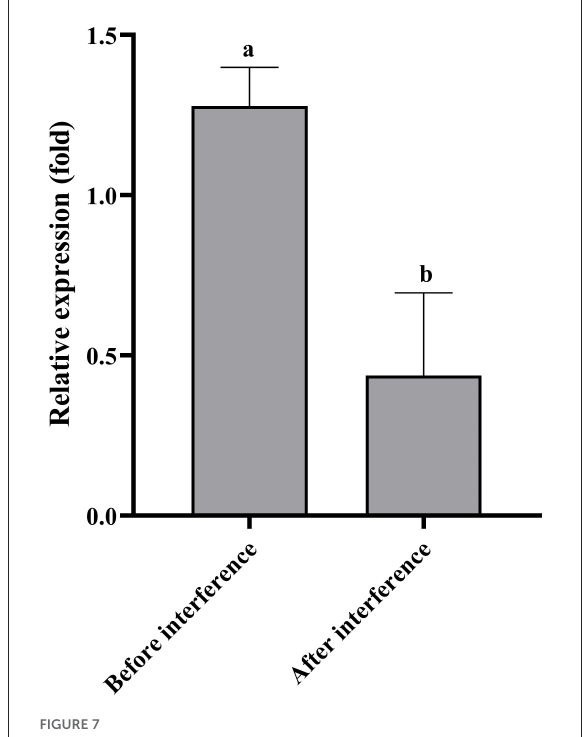
FIGURE7 RNAi efficiency verification of H. doenitzi. Student’s t test was conducted to analyze the data. Different letters indicate a significant difference between the two groups ( P < 0.05).